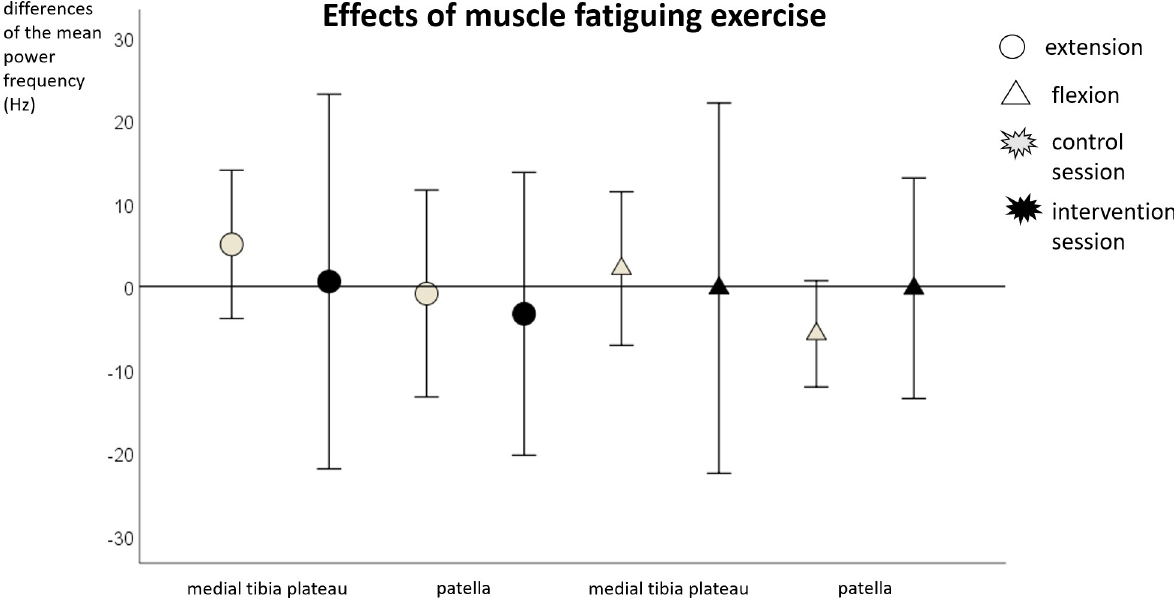
Fig 6. Mean and 95% confidence interval values of the pre-post differences of the median power frequency during extension and flexion for muscle fatigue.